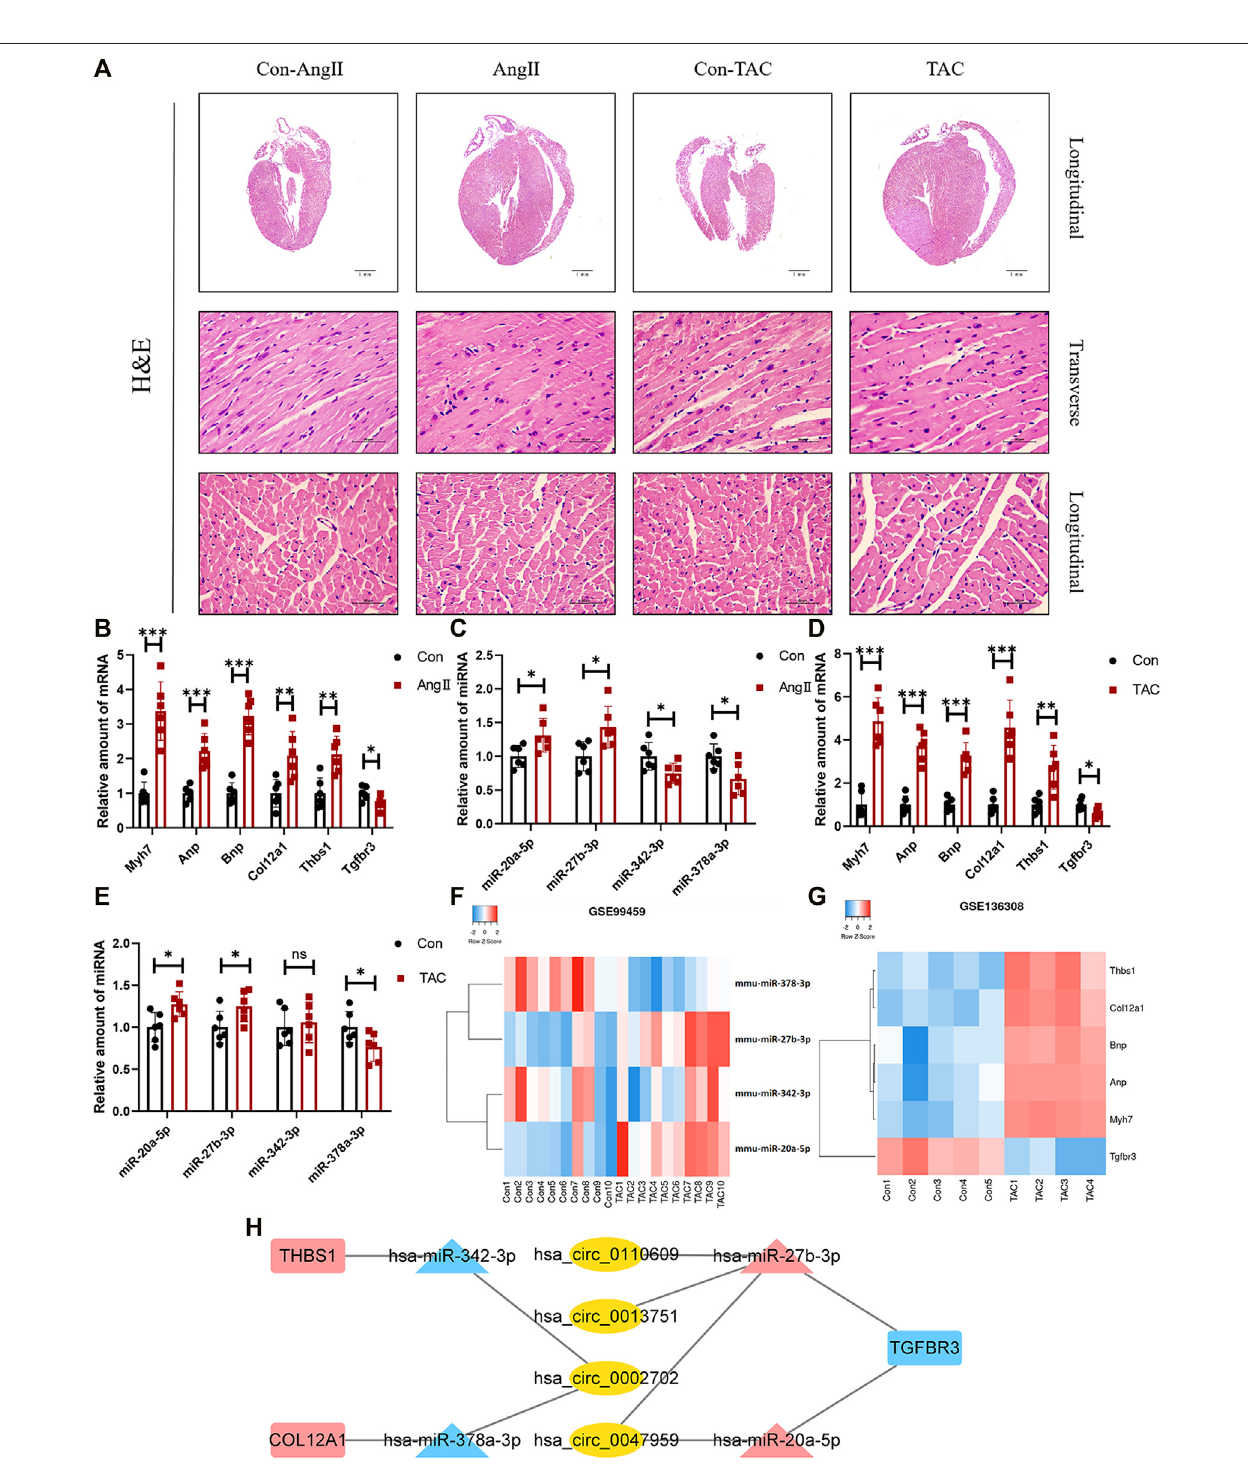
FIGURE6| Con fi rmation ofmicroarrayresultsinanimalmodels ofmyocardialhypertrophy. (A) Representativeimages ofH&Estaining(400×). (B – E) Expressionof Myh7,Anp,Bnp,Col12a1,Thbs1,Tgfbr3,miR-20a-5p,miR-27b-3p,miR-342-3p,andmiR-378a-3pinanimalmodelsofcardiachypertrophy.(n=6pergroup,* p -value < 0.05, ** p -value < 0.01,*** p -value < 0.001versusAngIIgroupor TACgroup.) (F,G) ExpressionofCol12a1, Thbs1,Tgfbr3, miR-20a-5p,miR-27b-3p,miR-342-3p,and miR-378a-3p in GSE99459 and GSE136308. (H) Hub ceRNA network.